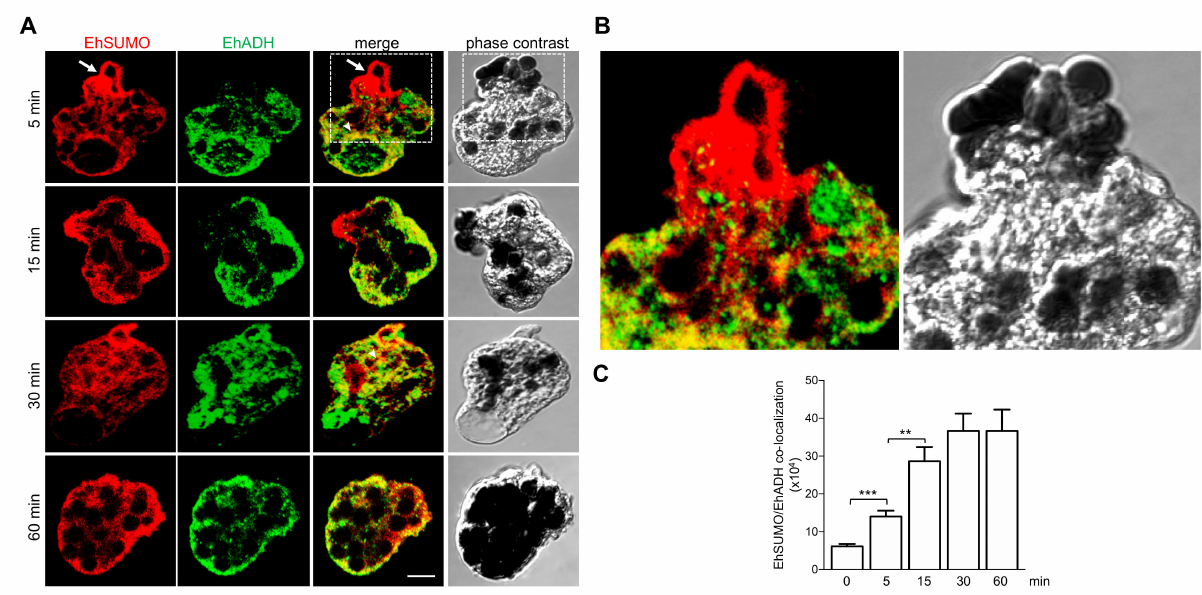
Figure 7. Location of EhSUMO and EhADH during phagocytosis. Trophozoites were incubated Figure 5. 15, 30, and 60 min with erythrocytes and processed for confocal microscopy. ( A ) Immunofluorescence assays using α -EhSUMO (red) and α -EhADH (green) antibodies. Arrow: EhSUMO in erythrocytes being phagocytosed. Scale bar = 10 µ m. ( B ) Magnification of squares in ( A ). ( C ) Quantification of EhSUMO and EhADH colocalization in the whole cells. (**) p < 0.01 (***) p <